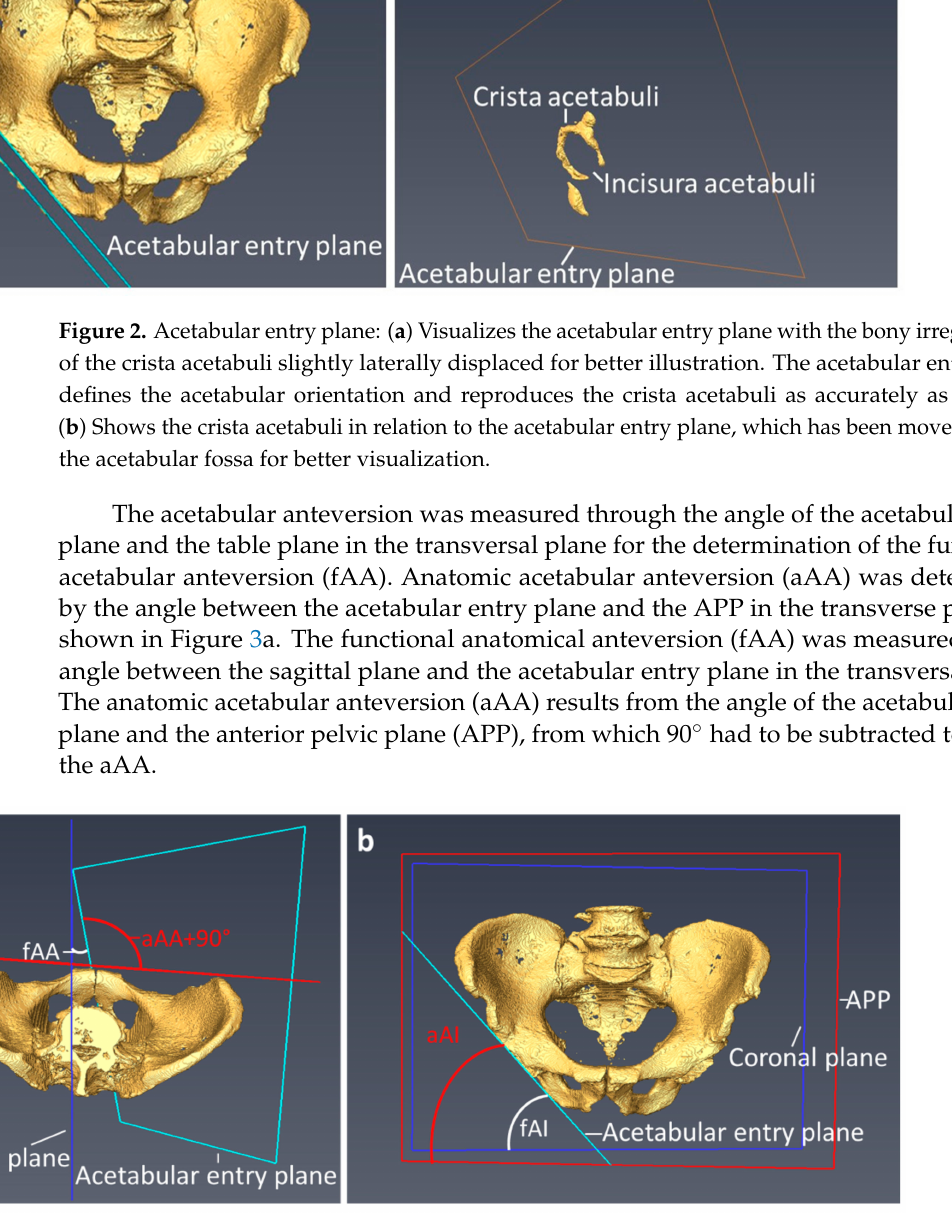
Figure 3. Measurement of the functional and anatomical acetabular orientation: ( a ) Shows the measurement of acetabular anteversion. ( b ) Demonstrates the measurement of acetabular inclination. APP = Anterior pelvic plane, fAA = functional acetabular anteversion, aAA = anatomical acetabular anteversion, fAI = functional acetabular inclination, aAI = anatomical acetabular